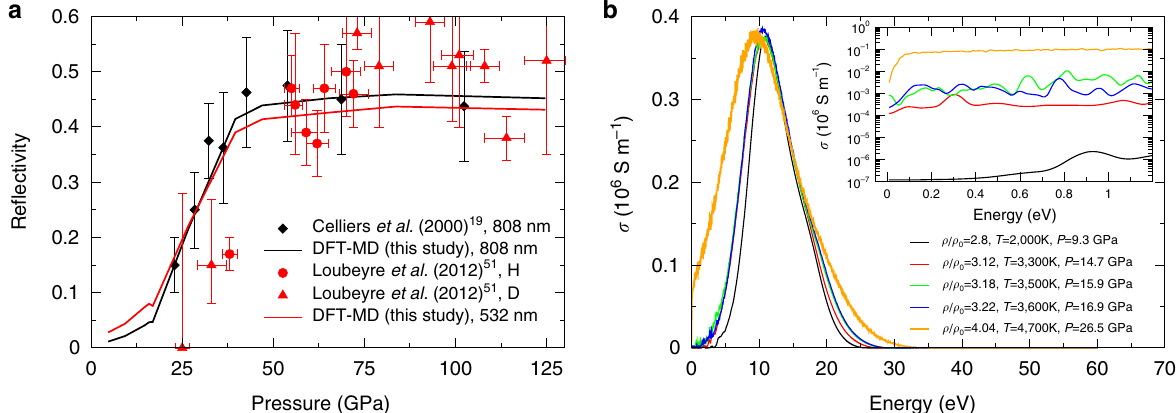
Figure 7 | Reflectivity and conductivity calculated from DFT-MD simulations. ( a ) Reflectivities along the principal Hugoniot curve for 808nm from the experiments of Celliers et al. (black diamonds) and DFT-MD calculations in this work (solid black line). Reflectivities for 532nm from the experiments of Loubeyre et al. in hydrogen (red dots) and deuterium (red triangles) and DFT-MD calculations in this work (solid red line). ( b ) Dynamic electrical conductivity at the five experimental points for which the thermodynamic states along the principal Hugoniot curve are given in the legend. The dc limit ( o - 0) is displayed in the